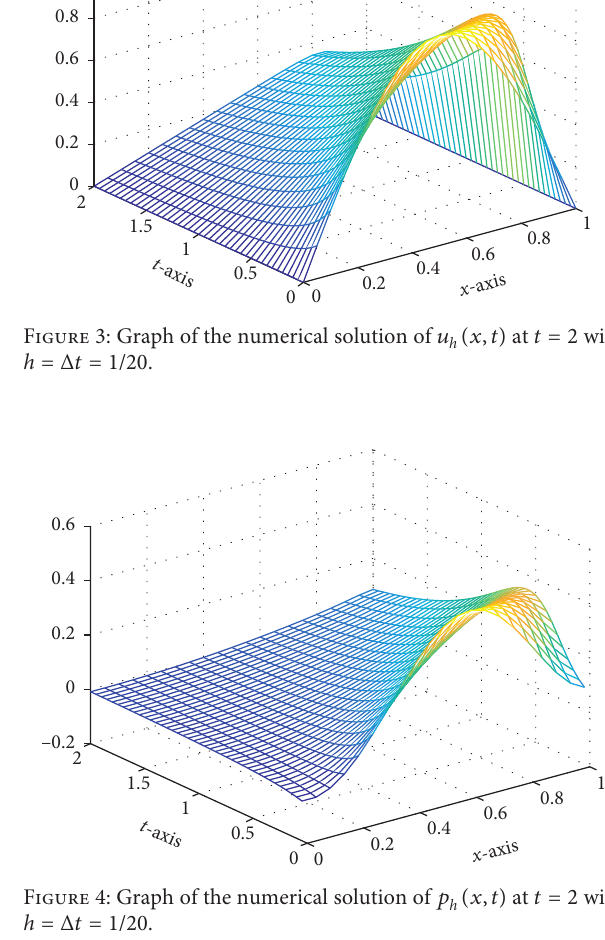
( x,t ) at t � 2 with h